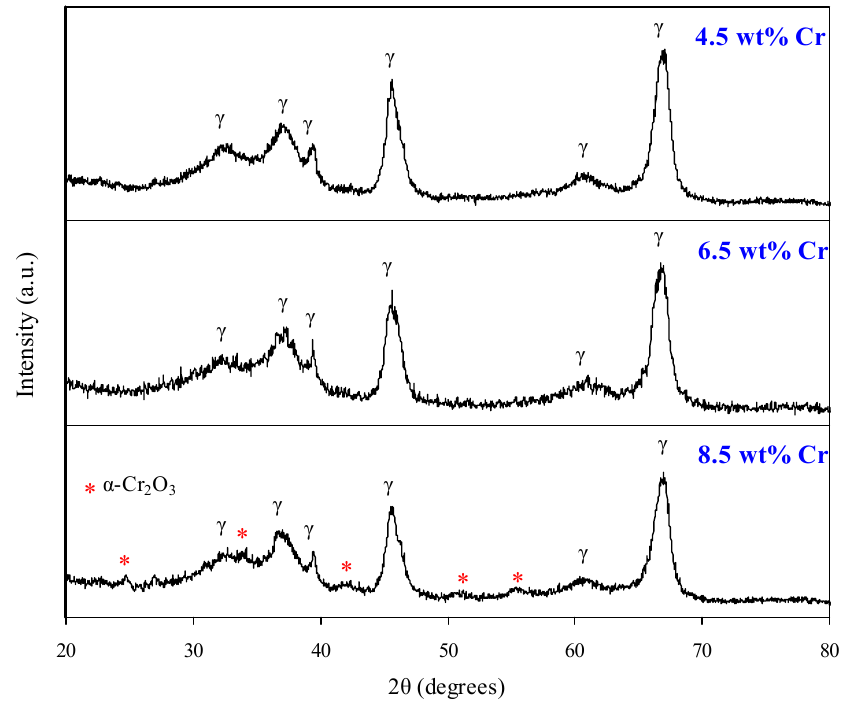
Table 4. The composition of catalysts and their performance in isobutane dehydrogenation.